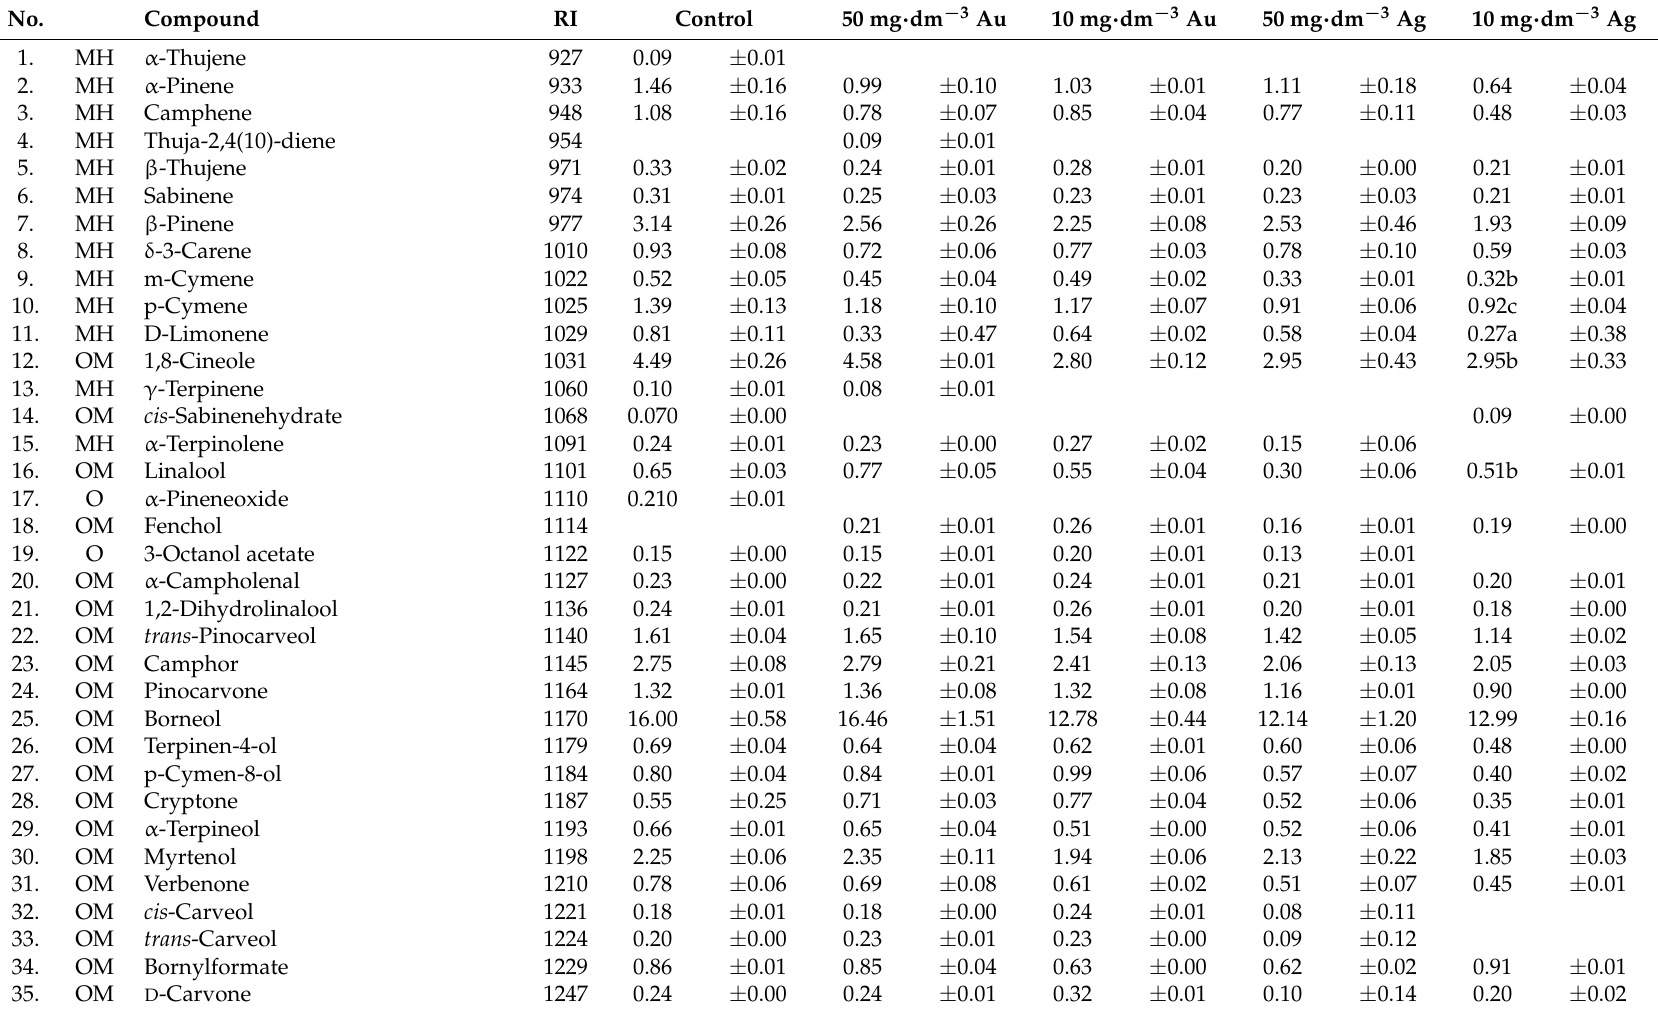
Table 3. Relative percentage composition of lavender essential oils depending on the medium ± SD ( n =